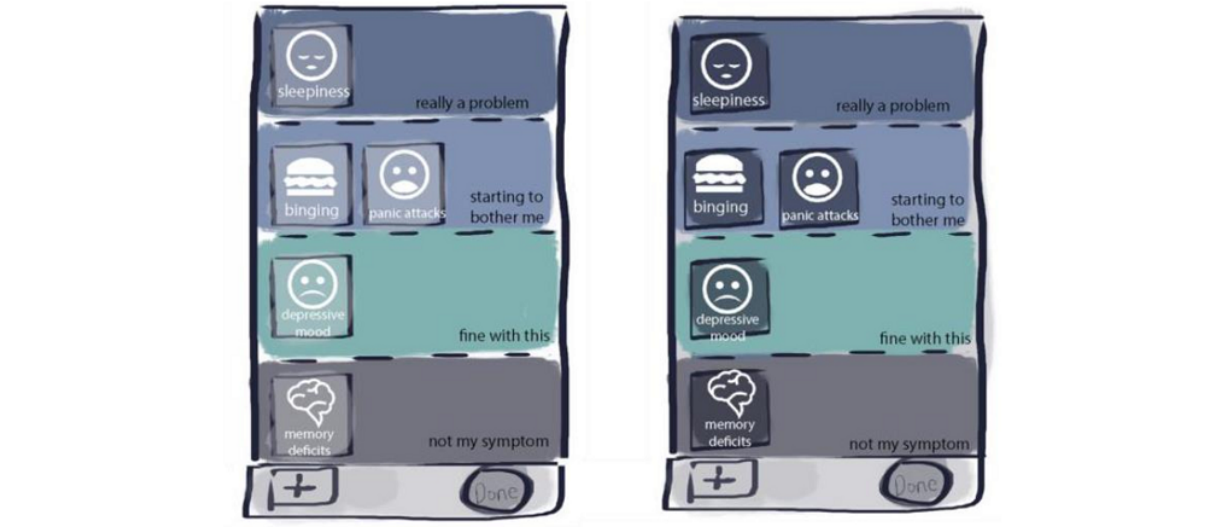
Figure 2. Concept for a symptom ranking